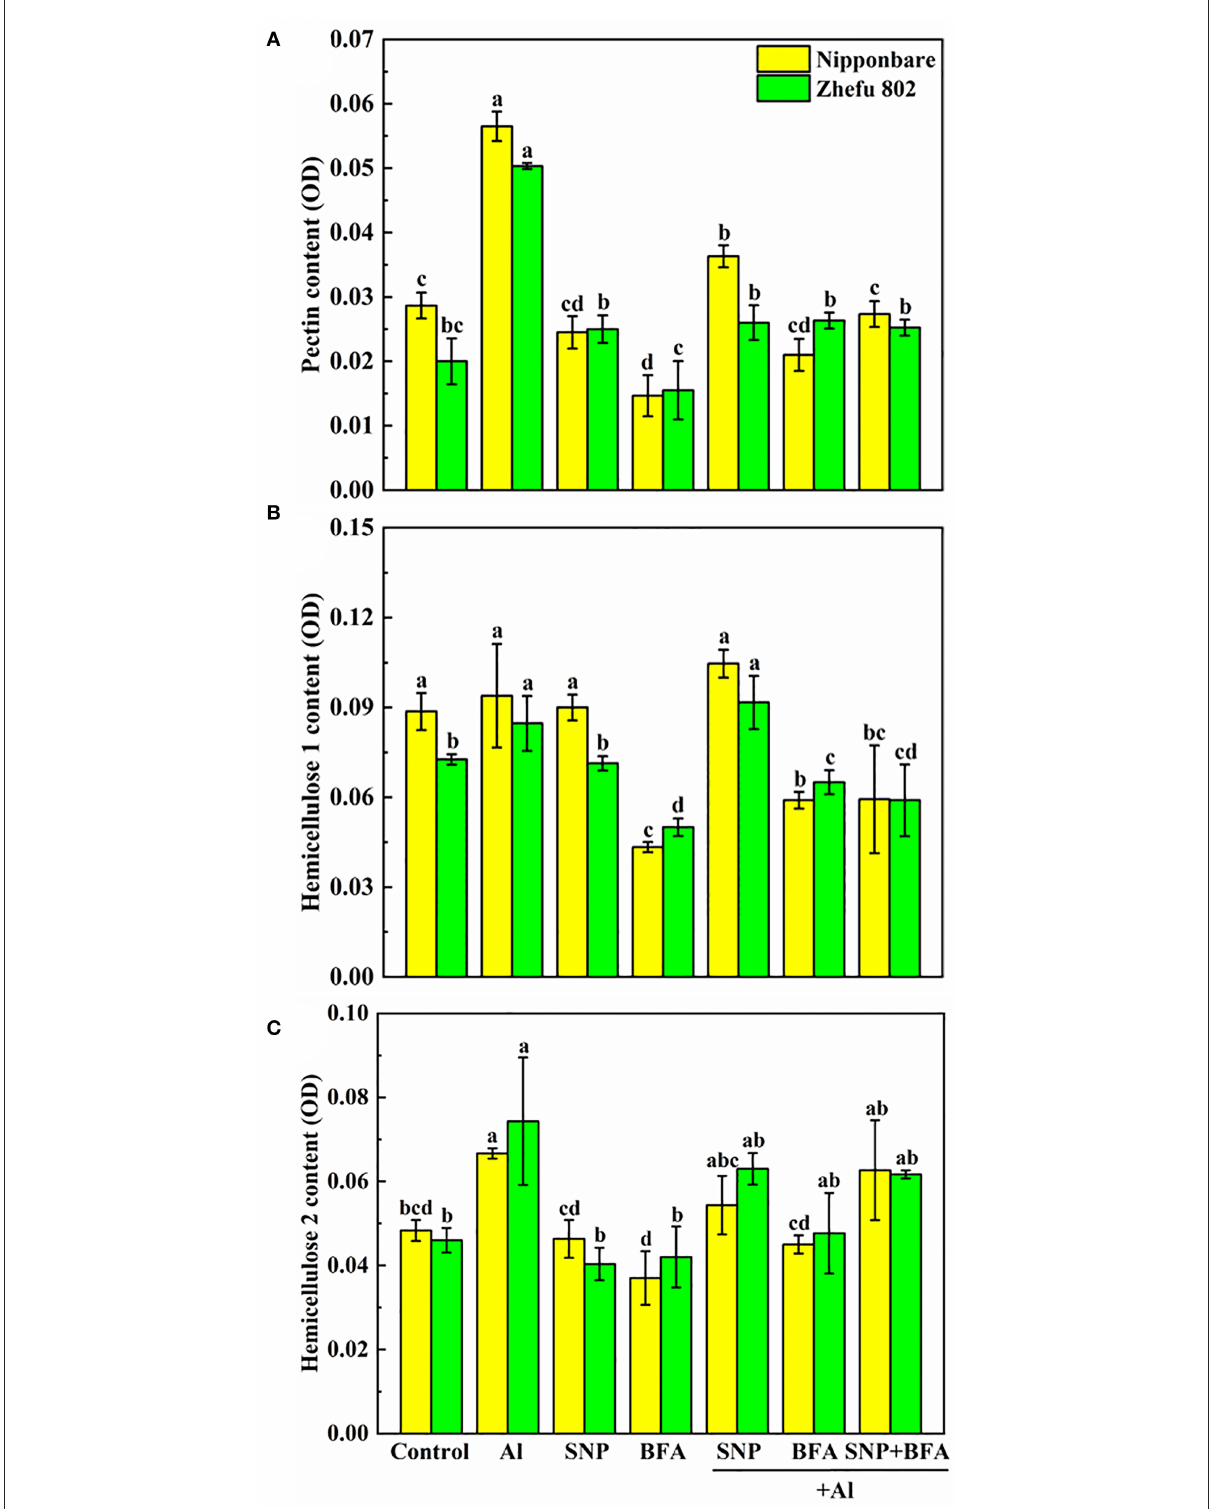
FIGURE5 Effect of BFA and SNP on cell wall composition in rice root tips (A) pectin content, (B) hemicellulose 1 content, and (C) hemicellulose 2 content. Columns with different letters are significantly different at P < 0.05 .